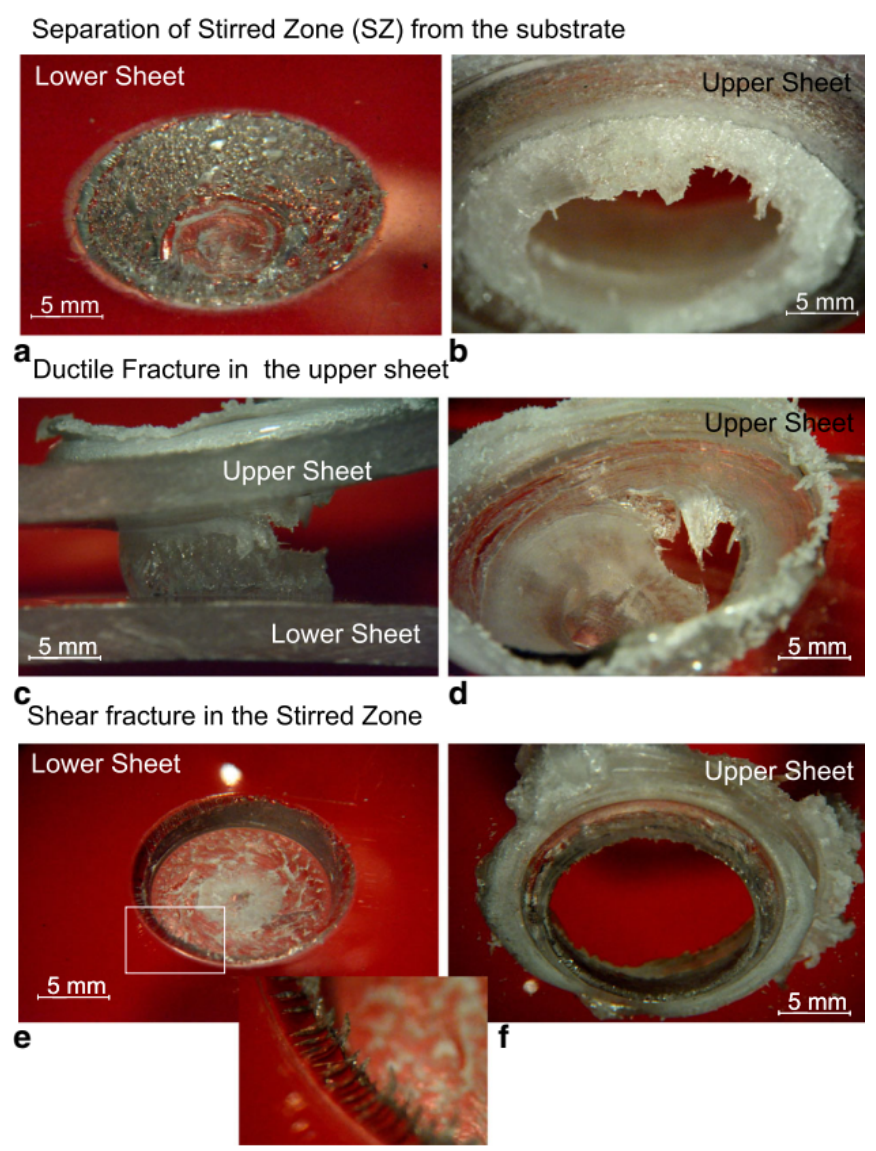
Figure 29. Typical failure modes of friction stir spot welds [77]. Separation of the SZ from the substrate in ( a ) lower sheet and ( b ) upper sheet. Ductile fracture in the upper sheet ( c ) side view and ( d ) upper view. ( e , f ) shear fracture in the stirred zone.